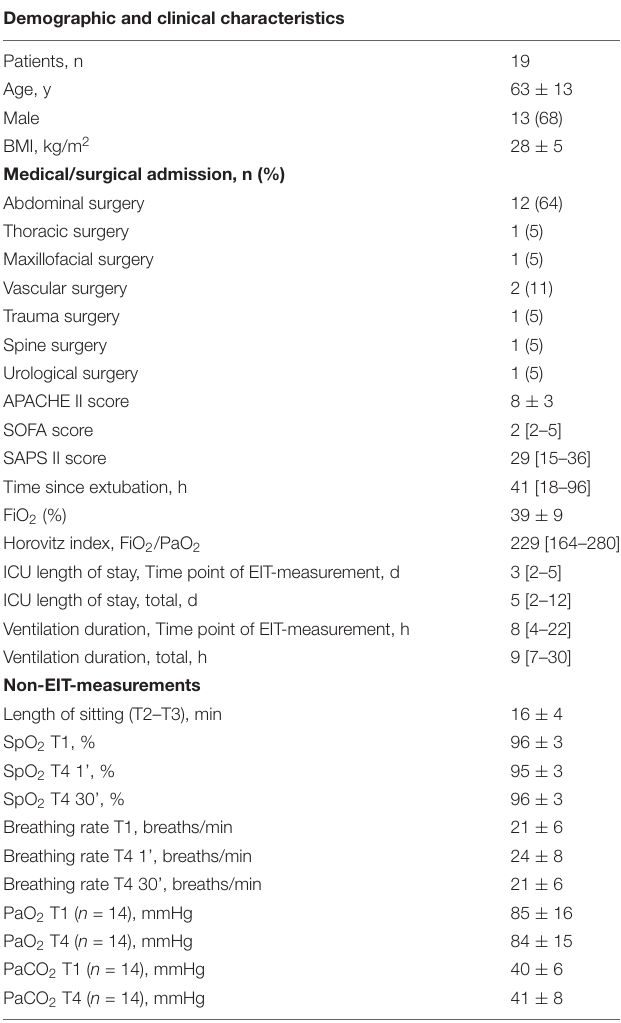
TABLE 1 | Demographic and clinical characteristics and